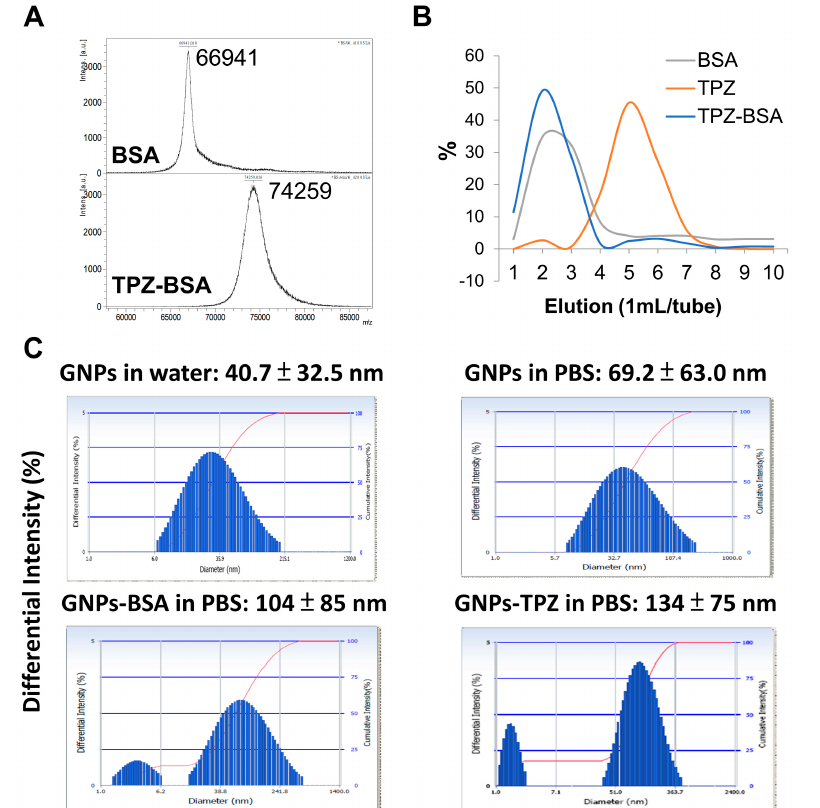
Figure 2. Bovine serum albumin (BSA) severed as coupling agent of TPZ. The molecular weight of BSA was measured as ~66.9 kDa, and the conjugated BSA–TPZ was 74.2 kDa measured by using a MALDI–TOF-MS analyzer ( A ). The conjugated BSA–TPZ was collected in elution 2 and measured at 450 nm, using a Sephadex G-25 column, and confirmed by Bio-Rad Protein Assay ( B ). The distributions in size were measured by using dynamic light-scattering analysis. Particle sizes were 69 ± 63 nm for pure GNPs, 104 ± 85 nm for GNPs–BSA conjugates, and 134 ± 75 nm for GNPs–TPZ conjugates ( C